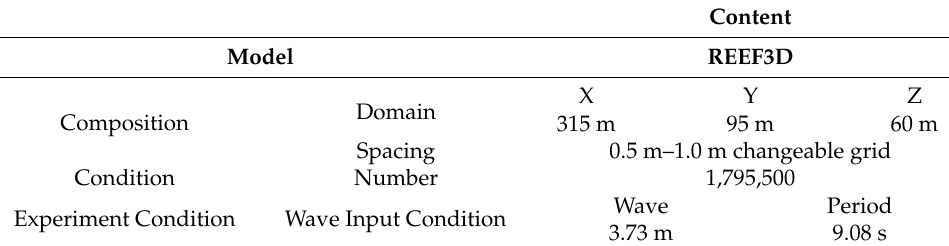
Table 3. An overview of the numerical wave flume test (REEF3D).